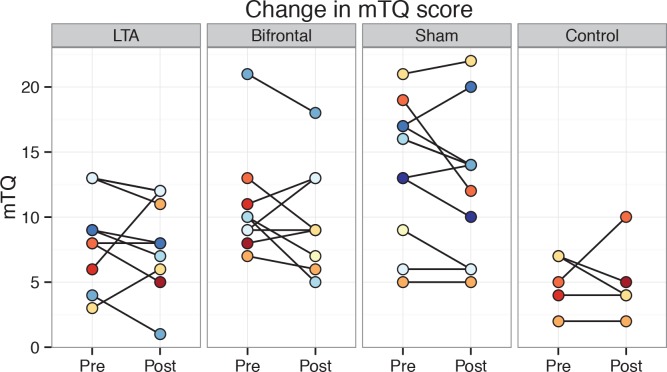
Individual mTQ scores pre- and post-treatment shown group-wise.